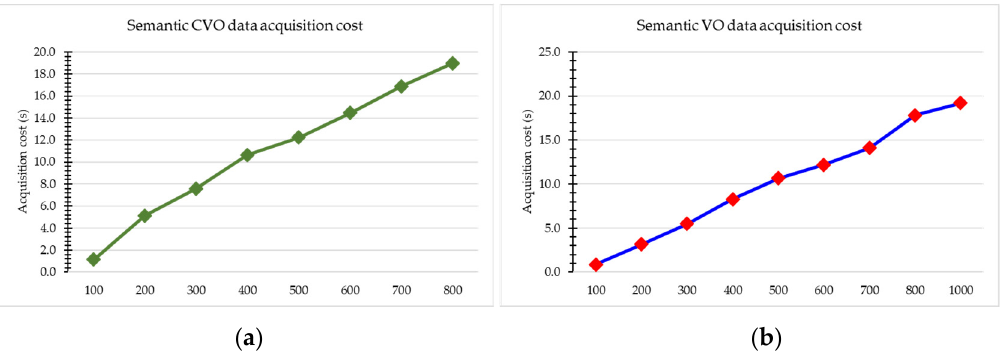
Figure 29. Semantic CVOs ( a ) and VOs ( b ) ontological data acquisition cost during the analytics.